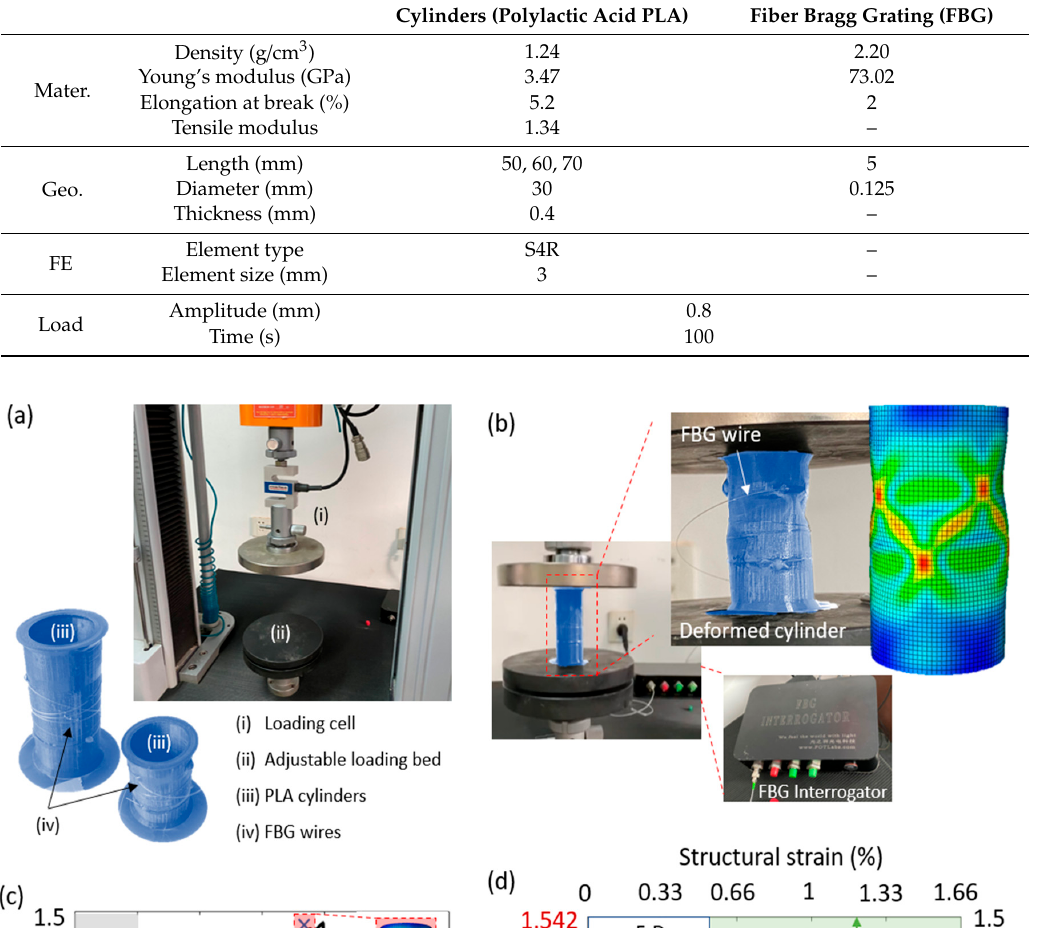
Table 1. Geometric and material properties, element type, and size in finite element (FE) modeling, and loading conditions.